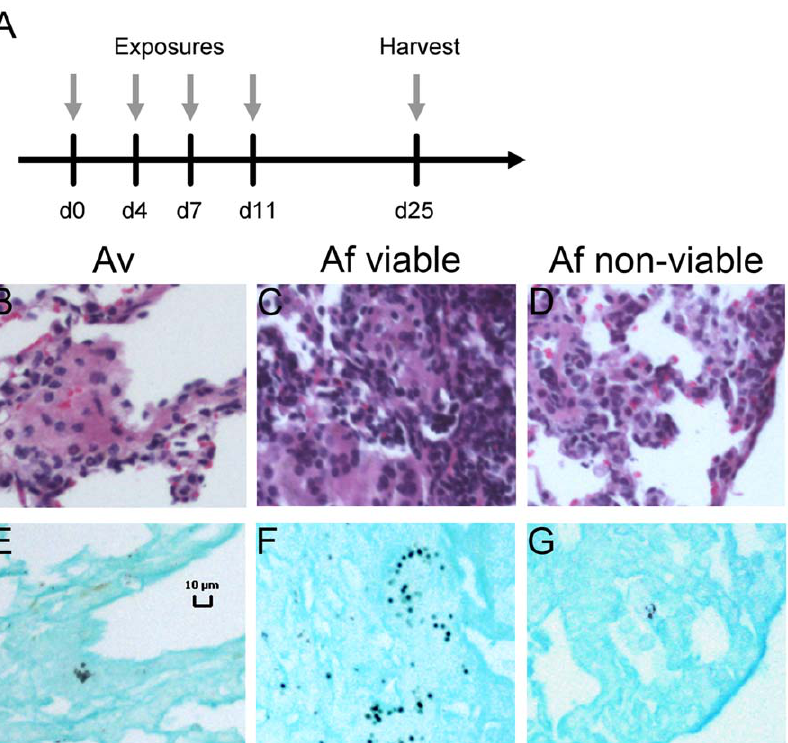
Figure 5. Increased persistence of A.fumigatus in lung tissue two weeks after exposure. A, mice aspirated viable or non-viable A. fumigatus or A. versicolor conidia at the time points indicated, and were sacrificed two weeks after the final aspiration. B–D, H&E staining (20 6 ) of a representative lung tissue sample from each group. E–G, GMS staining (20 6 ) from sections adjacent to H&E stained tissue indicate persistent fungal material. Panels are representative of 5 mice per group with one lung section analyzed per